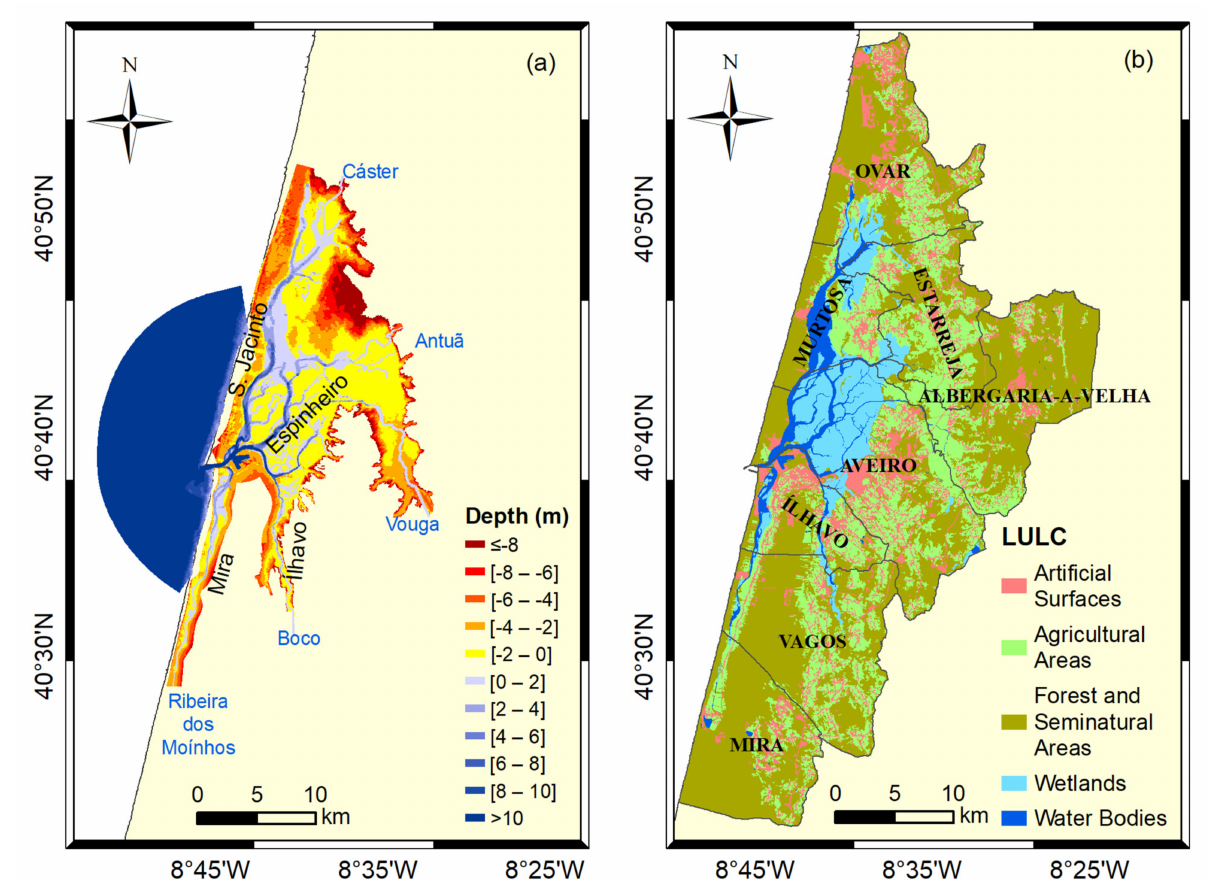
Figure 1. Topo-bathymetry of the Ria de Aveiro and its main channels and rivers ( a ); municipalities’ boundaries and land use (http://www.dgterritorio.pt, accessed on 1 December 2021) ( b